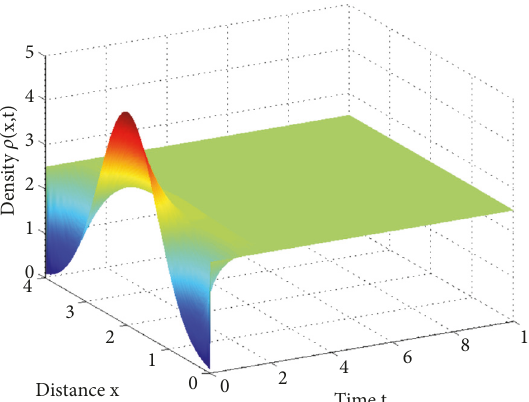
Figure 4: Finite-time tracking control with constant reference 𝑅 𝑐 = 2.5